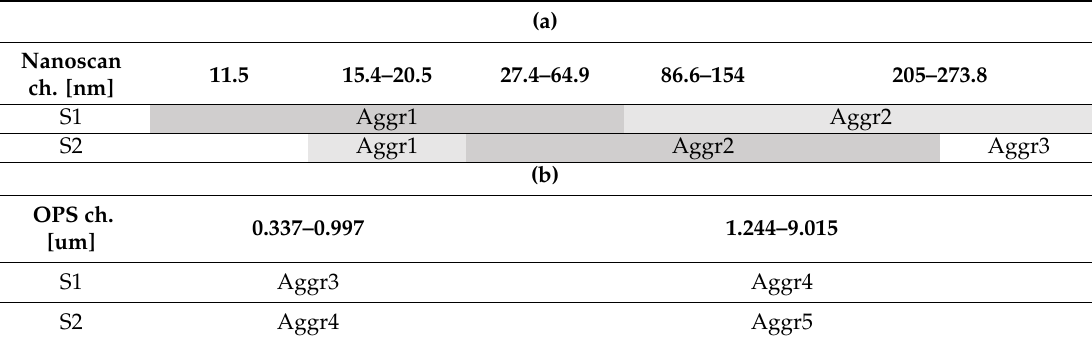
Figure 3. Correlation matrix of quantities measured in ( a ) School 1 and ( b ) School 2. Shades of red are used for positive correlations, and shades of blue for negative correlations. (Plots were produced in Python 3.7.4 environment using libraries Seaborn 0.9.0 [23] for visualization and Pandas 0.25.2 [24] for data processing and calculations.) Table 2. Aggregation of particle channels into larger bins based on correlation matrix in Figure